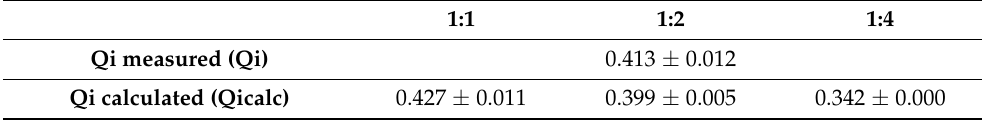
in Qi-HSA complex 1:1, 1:2, and 1:4 molar ratio; [Qi] 7 × 10 − 5 M, [HSA] 7 × 10 − 5 M, 1.4 × 10 − 4 M, 2.8 × 10 − 4 M; all tested solutions were prepared in phosphate buffer (pH 7.4).